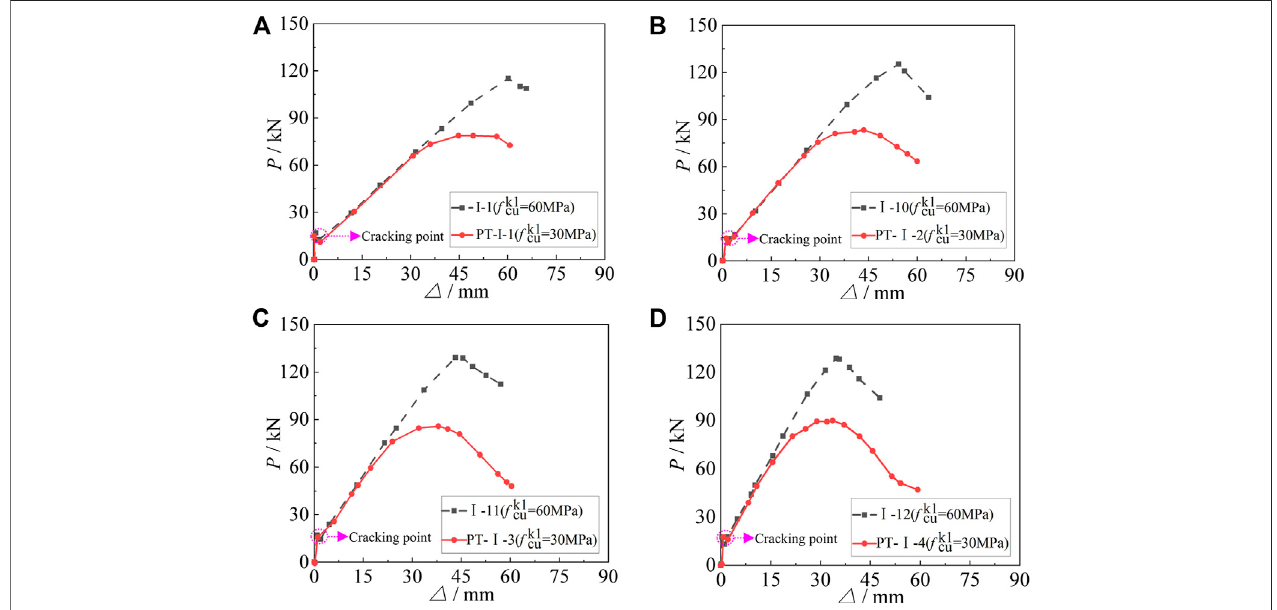
FIGURE12| Comparison ofload – displacement curvesbetweensimplysupported beamsconsistingofHSCandNSC: (A) ρ GFRP (cid:2) 1.14%; (B) ρ GFRP (cid:2) 1.49%; (C) ρ (cid:2) 1.88%; (D) ρ (cid:2) 2.33%. GFRP GFRP